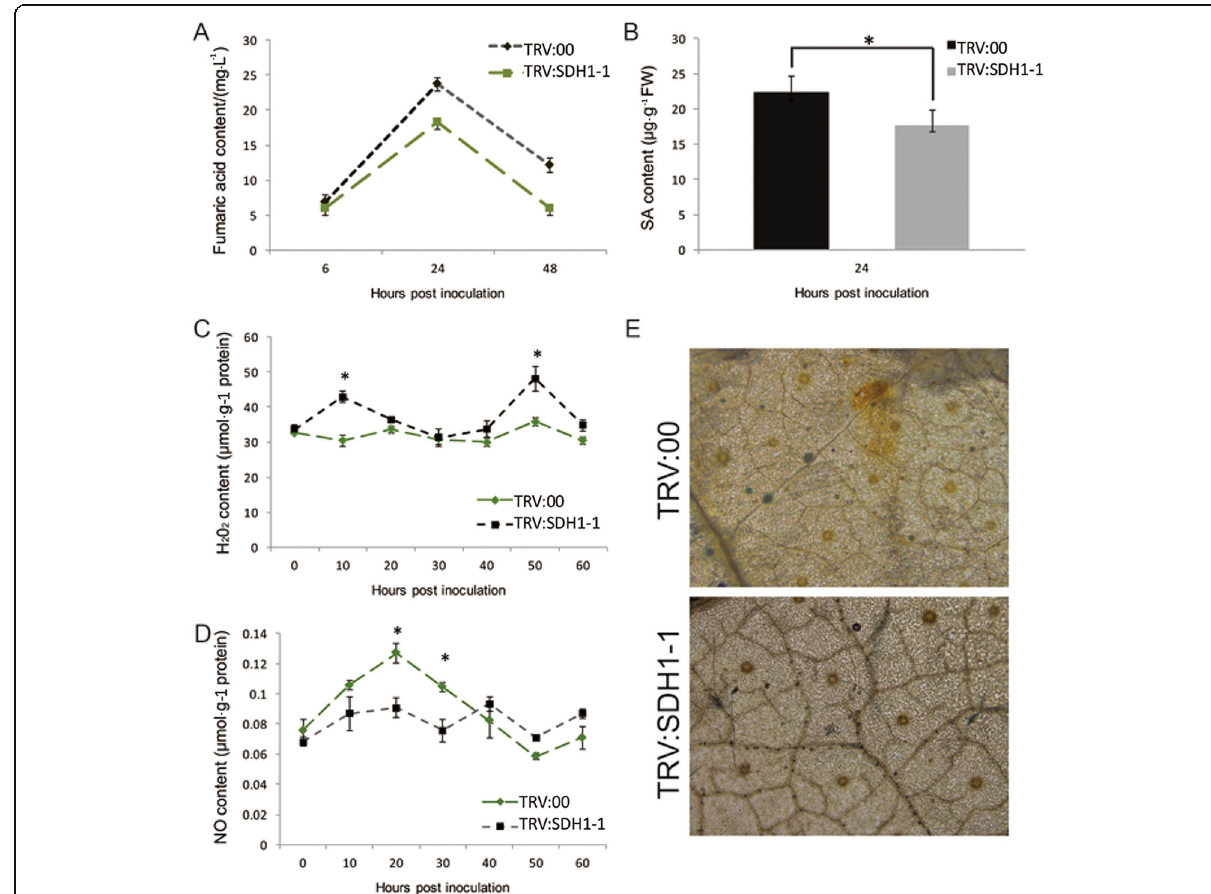
Fig. 4 The abundance of fumaric acid, SA and several other immune-responsive compounds (NO, H 2 O 2 ) in V. dahliae treated silencing and control plants. a , The abundance of fumaric acid. b , The abundance of SA. c , d , The content of H 2 O 2 and NO in GhSDH1 – 1 -silenced and control cotton plants within 1 h after inoculation. e , Diaminobenzidine (DAB) staining to the plants at inoculation 24